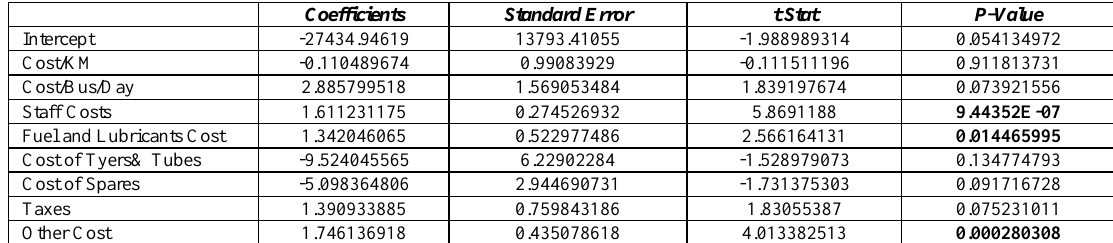
Table 5. Regression analysis for total